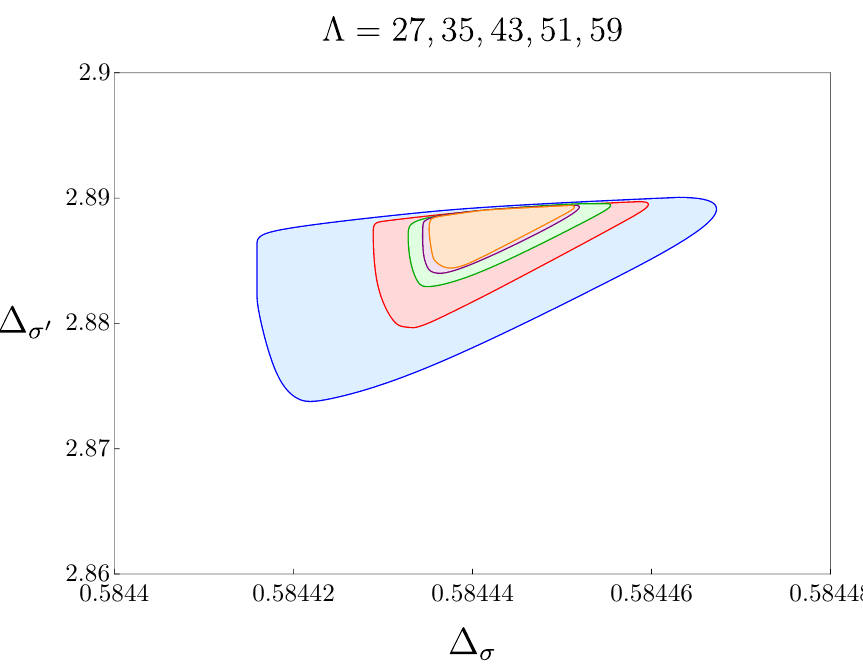
Figure 1 . Allowed region for the scaling dimensions of the leading parity-odd scalars { σ, σ 0 } in the 3d N = 1 super-Ising